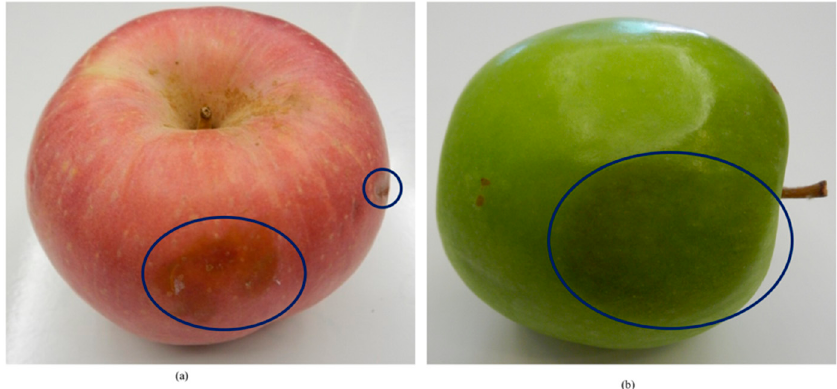
Figure 3. Examples of bruising defects ( a ) red skinned apple and ( b ) green skinned apple.